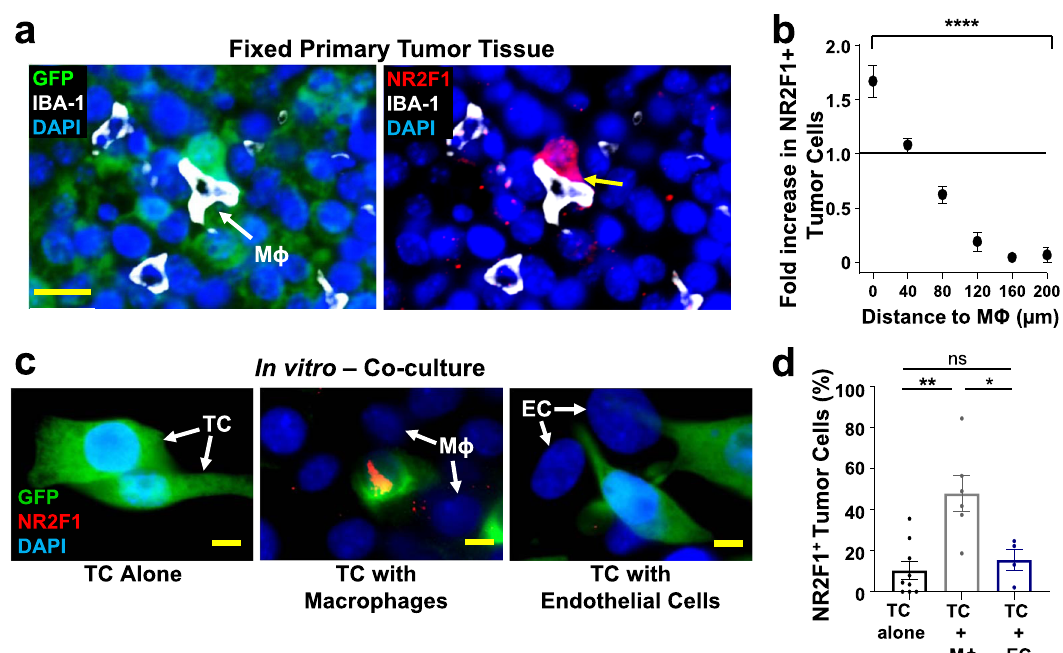
Fig. 7 Macrophages regulate dormancy in tumor cells. a Representative image of triple immuno fl uorescently stained in E0771-GFP primary tumor tissue for tumor cells, macrophages, and NR2F1. Green = GFP; Red = NR2F1; White = IBA-1; Blue = DAPI. White arrow shows a macrophage. The yellow arrow shows the contact between an NR2F1-positive tumor cell and a macrophage. M ϕ = Macrophage. Scale bar = 20 μ m. b Quanti fi cation showing the frequency of distances between NR2F1 + tumor cells to the nearest macrophage in the primary tumor. Data is normalized to the frequency of distances between all DAPI + nuclei to the nearest TMEM. Bar = mean. Error bars = ±SEM. n = 34 fi elds of view (551 × 316 µ m 2 ) in 4 animals. For comparison between the 0 and 200 µ m bins a two-tailed Mann-Whitney test was used ( p < 0.0001). **** p < 0.0001. c Representative immuno fl uorescence images of NR2F1 expression in E0771-GFP tumor cells cultured alone, in direct contact with BAC1.2F5 macrophages, or in direct contact with HUVEC endothelial cells. White arrows show macrophages or endothelial cells in direct contact with a tumor cell. Green = GFP; Red = NR2F1; Blue = DAPI. TC = Tumor Cell. M ϕ = Macrophage. EC = Endothelial Cell. Scale bar = 15 μ m. d Percentage of NR2F1-positive tumor cells from each group in C . TC alone: n = 777 cells in 9 independent experiments; TC + M ϕ ; n = 226 cells in 6 independent experiments, TC + EC = n = 359 cells in 4 independent experiments. Bar = mean. Error bars = ±SEM. For TC vs. TC + M ϕ ( p = 0.0039), and for TC vs. TC + EC ( p = 1), a two-tailed Kruskal-Wallis test with Dunn ’ s multiple comparisons adjustment was